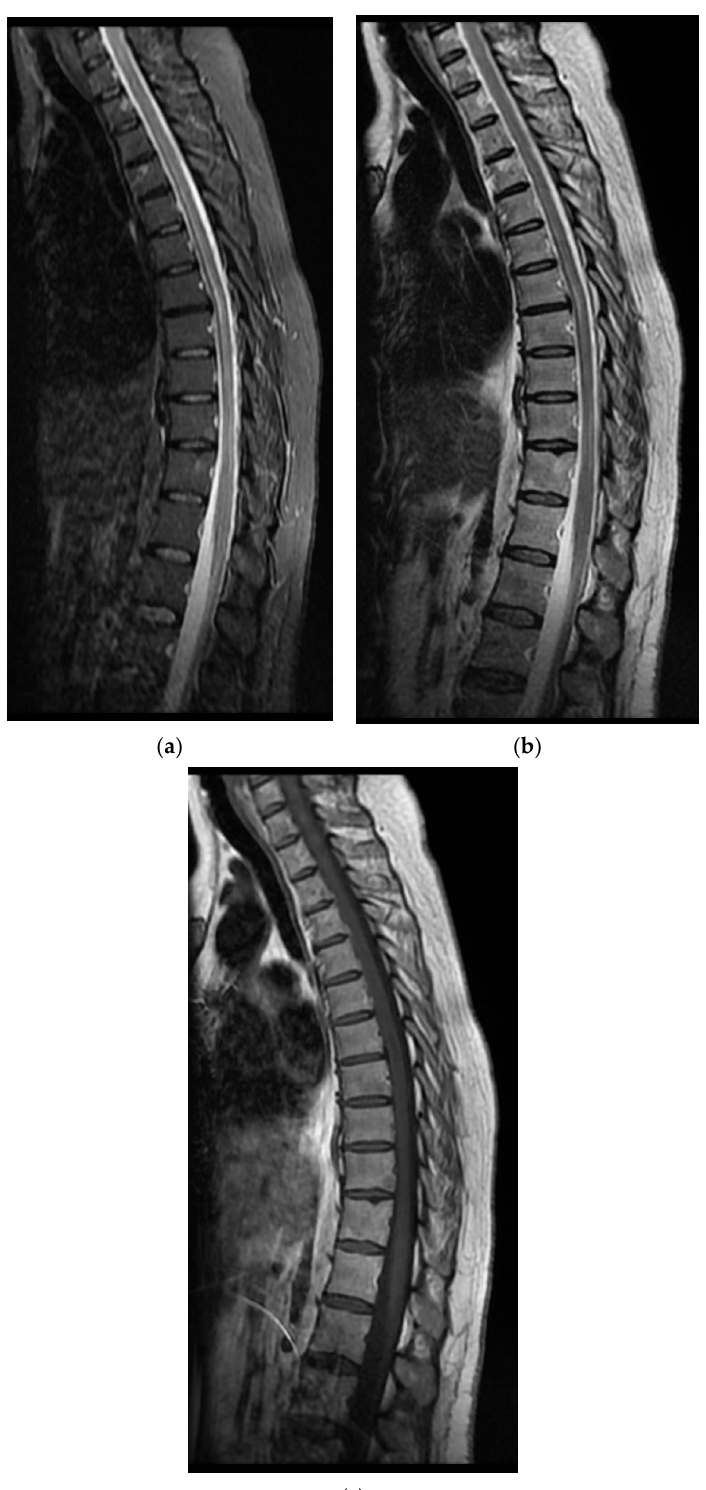
Figure 1. MRI images of the Case 1 patient show inaccurate delimited discrete hyperintense fore- shores T2-STIR ( a , b ), hypointense T1 ( c ), disposed at the level of lateral coordinates of the marrow corresponding to T6–T10 myeloma; thoracic intramedullary lesions with suggestive characters for an inflammatory-infectious